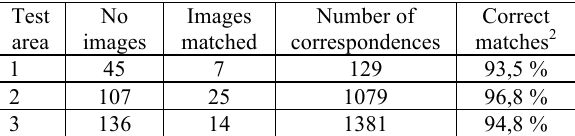
Table 1 Registration results for three urban test areas in Rotterdam, NL